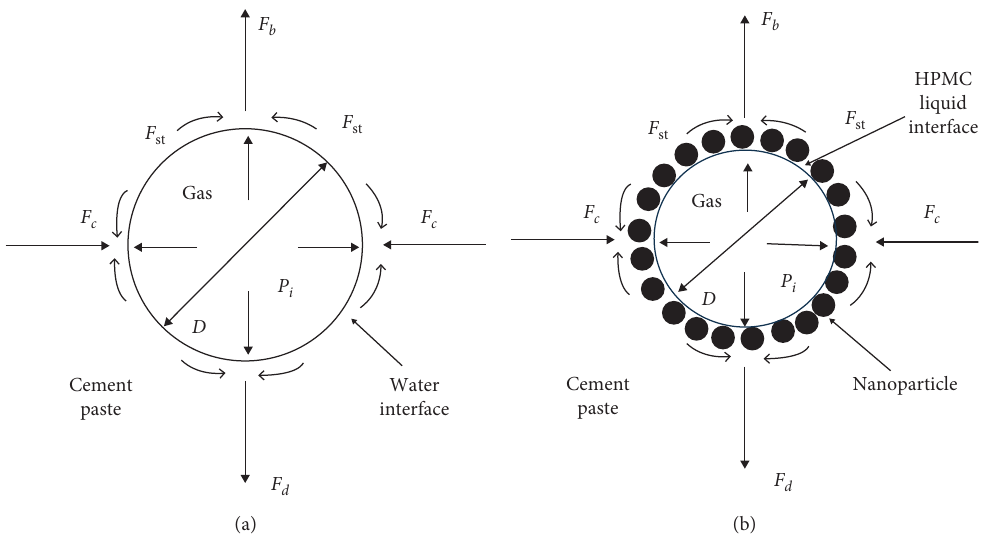
Figure 4: Forces acting on (a) a normal bubble and (b) a nanoparticle stabilized bubble